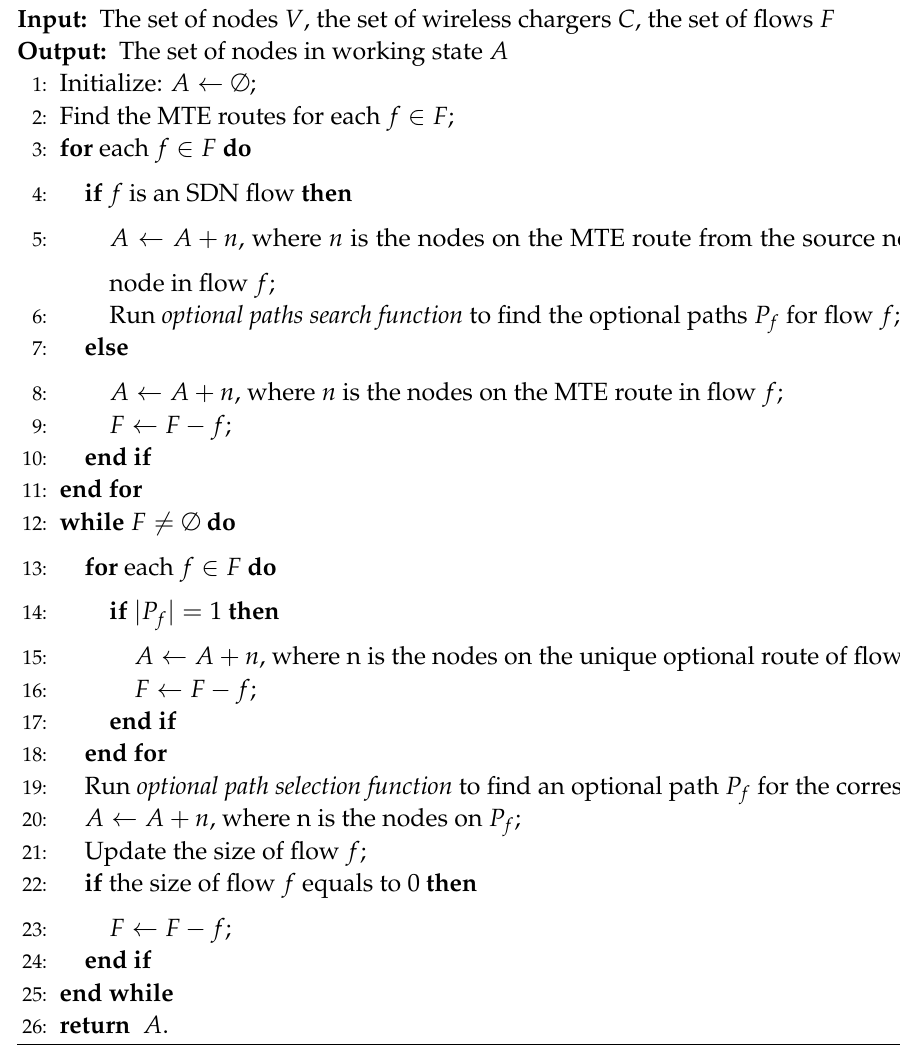
Algorithm 1 Energy-Saving Traffic